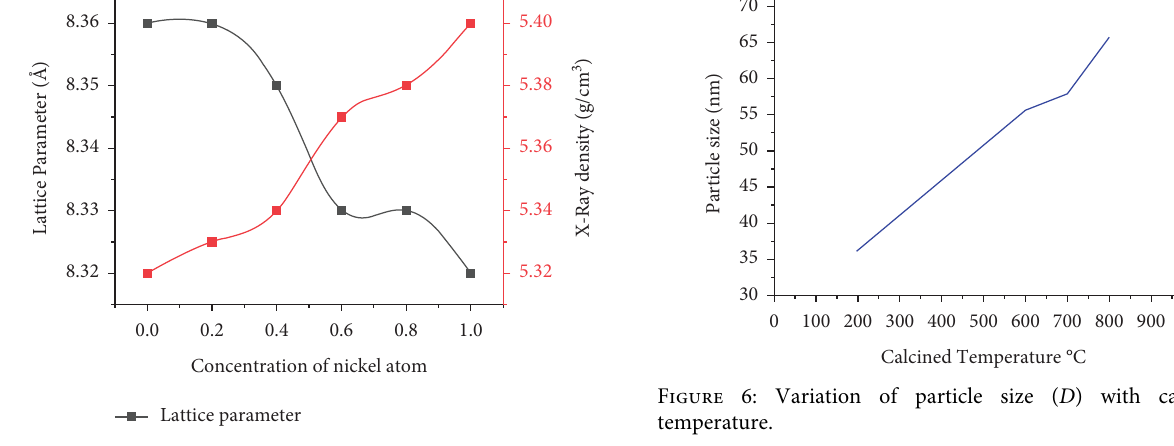
Figure 4: XRD pattern of all the compositions Co (311) peaks.